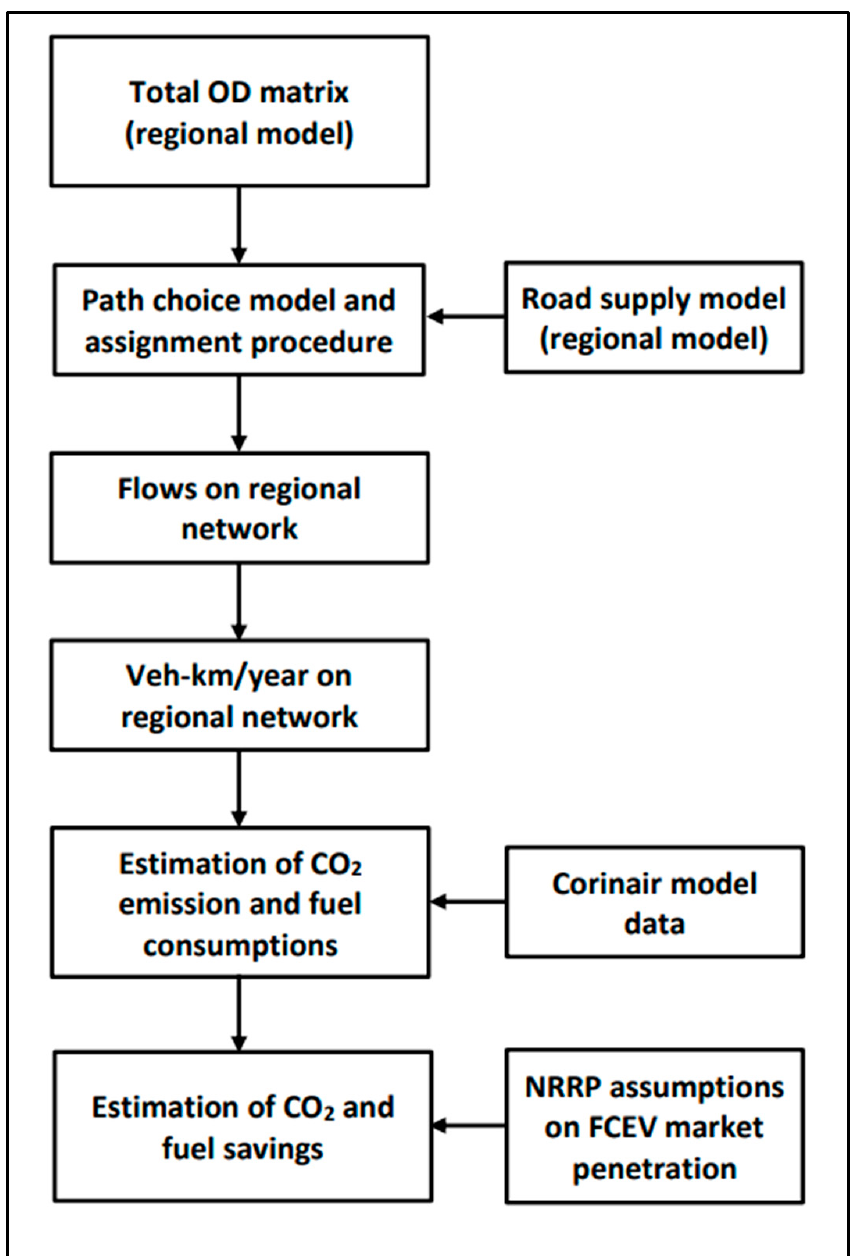
Figure 4. Procedure—Phase 3: vehicle-km/year and savings estimation.